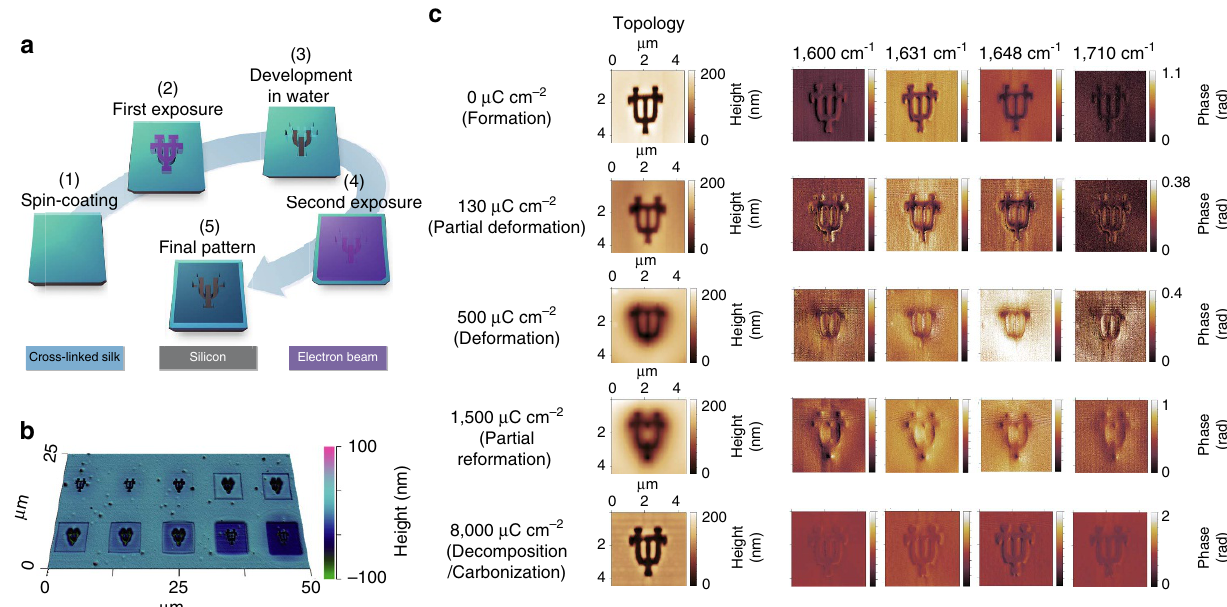
Figure 2 | Direct visualization of electron-directed structural transitions of b -sheets using near-field IR nano-imaging. ( a ) Illustration of a two-step EBL process for sample preparation. First, an area of 3 (cid:3) 3 m m (in the shape of a ‘UT’ logo, line width: 200nm) was patterned using EBL followed by a water development, which provided a clear contrast between silk and silicon and facilitated the following spectroscopic imaging/characterization. Then, a second step of electron irradiation was used to induce localized structural transitions in silk (5 (cid:3) 5 m m squares) by delivering ebeams at various dosages. ( b ) AFM topographic images of silk nanopatterns fabricated using EBL at the dosages ranging from 0 to 8,000 m Ccm (cid:2) 2 . ( c ) IR nano-imaging using s-SNOM: the phase contrast between silk and silicon (a flat spectral response in the mid-IR) in each IR image correlates to the absorption of silk proteins (that is, the surrounding area of ‘UT’ logos) of various structures at that wavenumber, and the comparison of contrast differences between the IR images (for instance, those in column 3 and column 4) implies the dominant protein structure within the amide I vibration bands (for example, 1,631cm (cid:2) 1 for b -sheets and 1,648cm (cid:2) 1 for random the phase images taken at 1,631 cm (cid:2) 1 show a marginally higher (but comparable) contrast to 1,648 cm (cid:2) 1 , which is believed to be